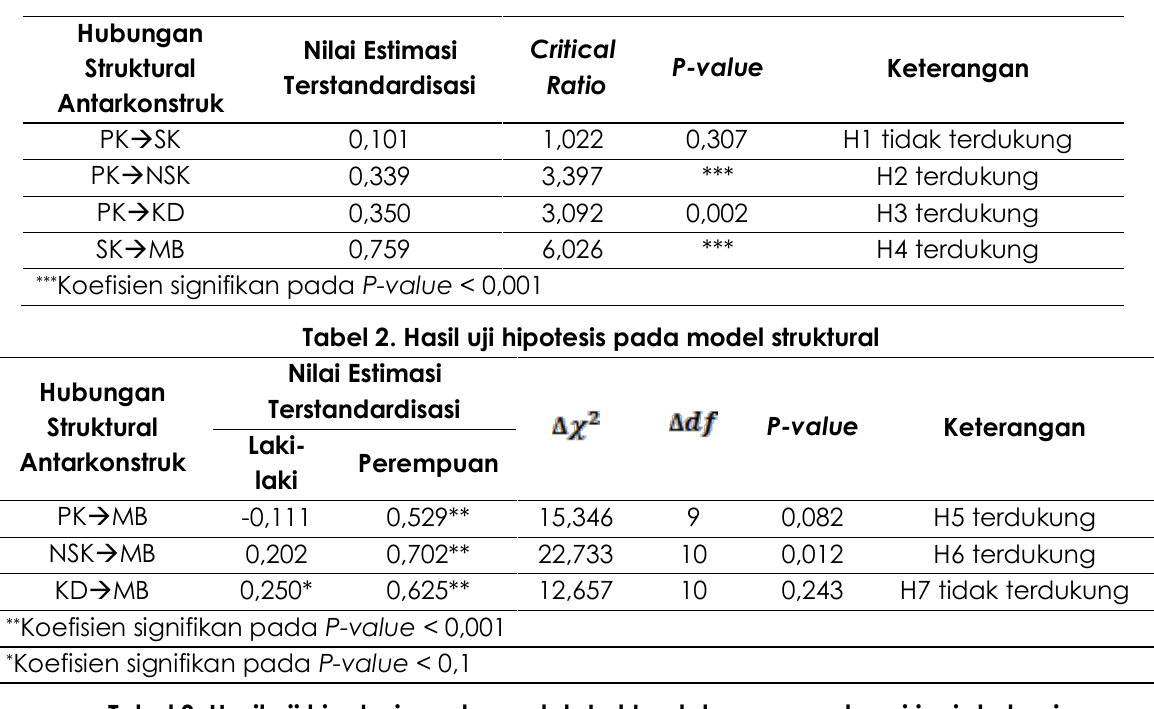
Tabel 3. Hasil uji hipotesis pada model struktural dengan moderasi jenis